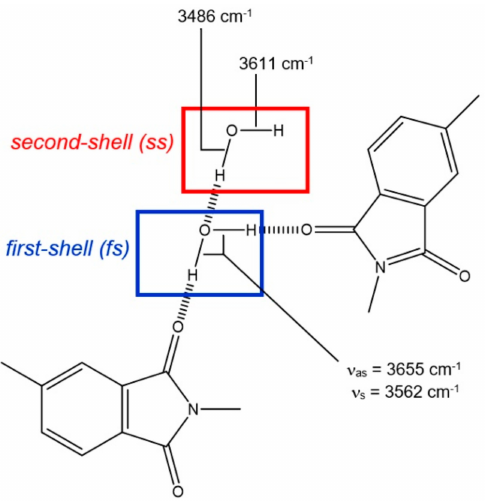
Figure 1. The water species identified spectroscopically, with indication of the signals they